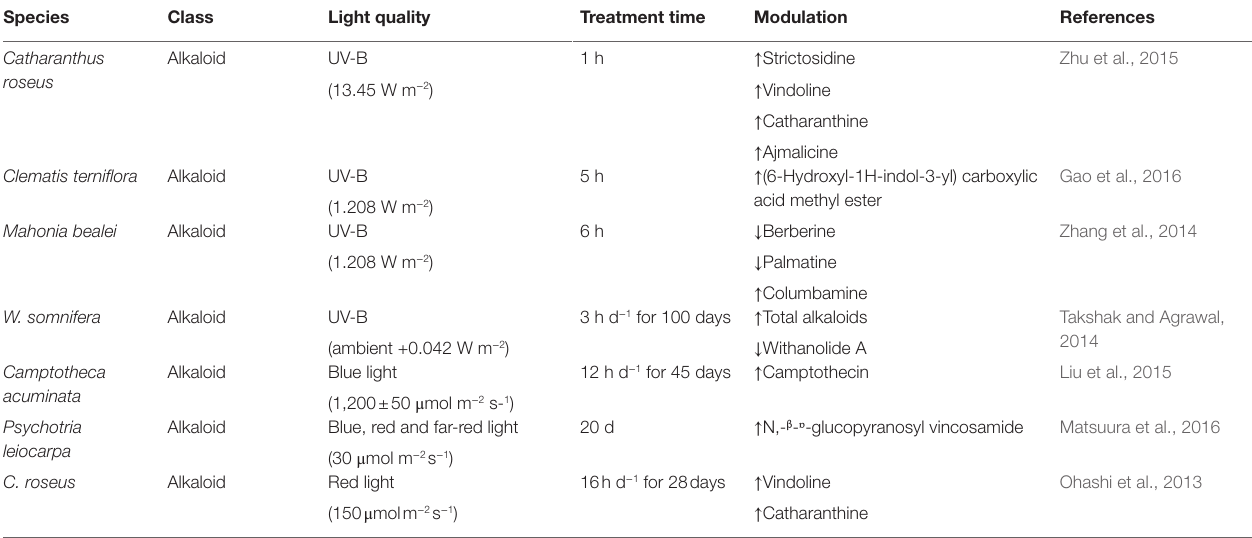
The upward arrow in the table represents the increased content of the corresponding phytochemical, the downward arrow in the table represents the decreased content of the corresponding